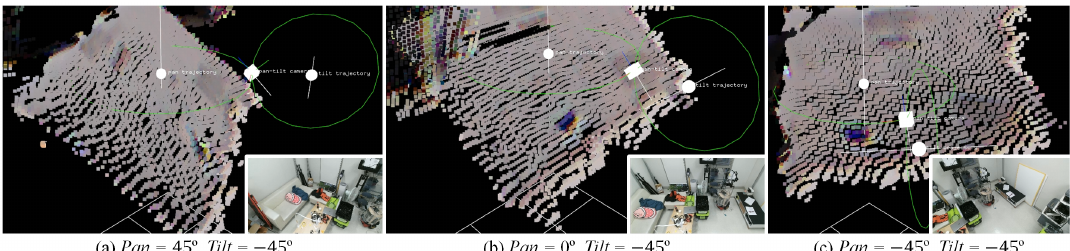
Figure 3. The rotation axis calibration results of the pan–tilt system. Pan and tilt trajectories were calculated (green circles). Note that the point cloud in the image is the projector that was captured from behind by the rear camera. Thus, the front camera was occluded, and its positions and poses were estimated in the figure labeled as the “pan–tilt camera” (white cubes). The images in the right-bottom corners are captured by the front camera to give the sense of its poses at the moment of the capture, during the